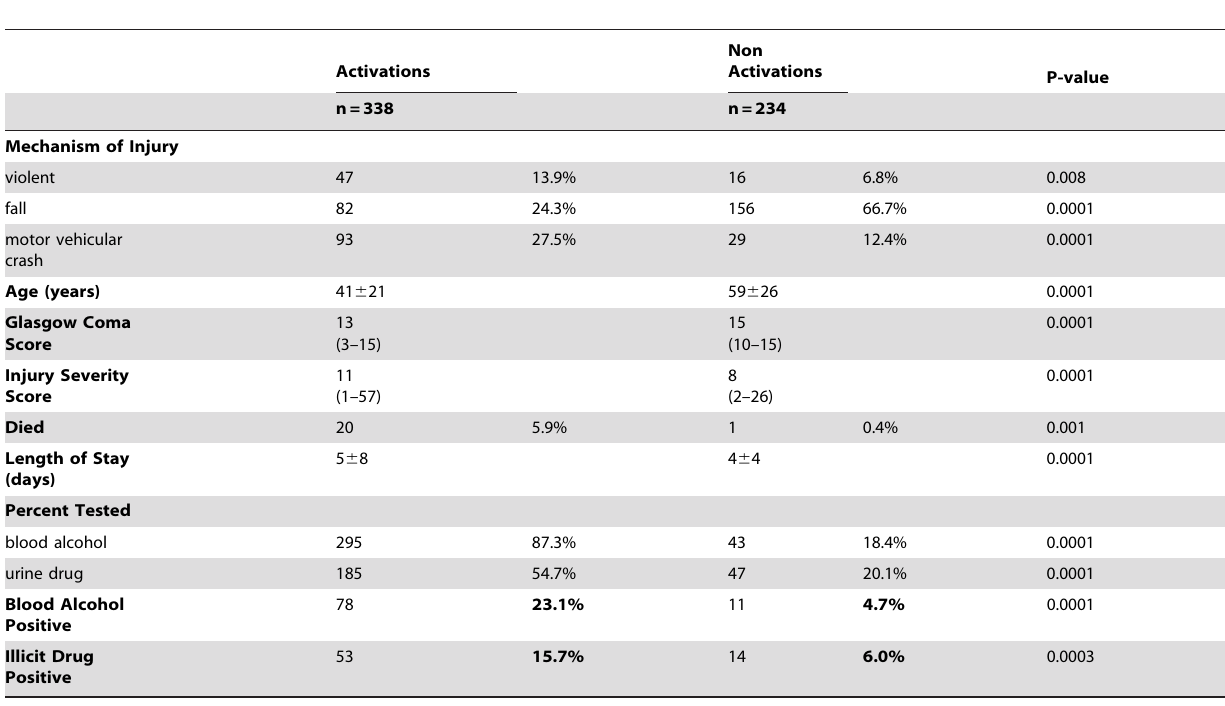
Table 4. Comparison of SEHC Trauma Activation Patients and SEHC Trauma Nonactivation Patients, minimum alcohol and illicit drug rates.